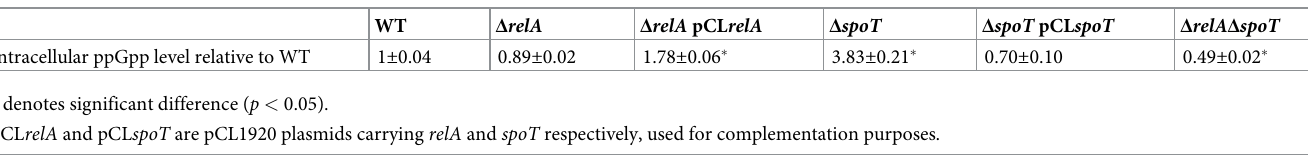
Table 1. Relative intracellular ppGpp level of ppGpp biosynthesis gene mutants andcomplementation